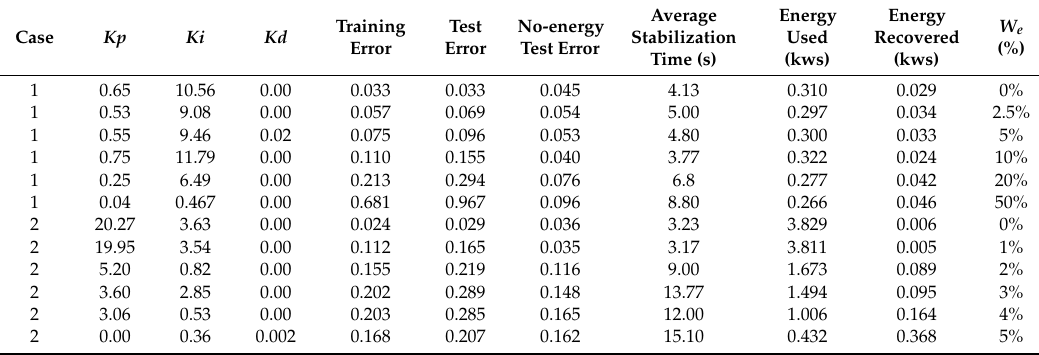
Table 4. Results of the optimization tests for the two cases